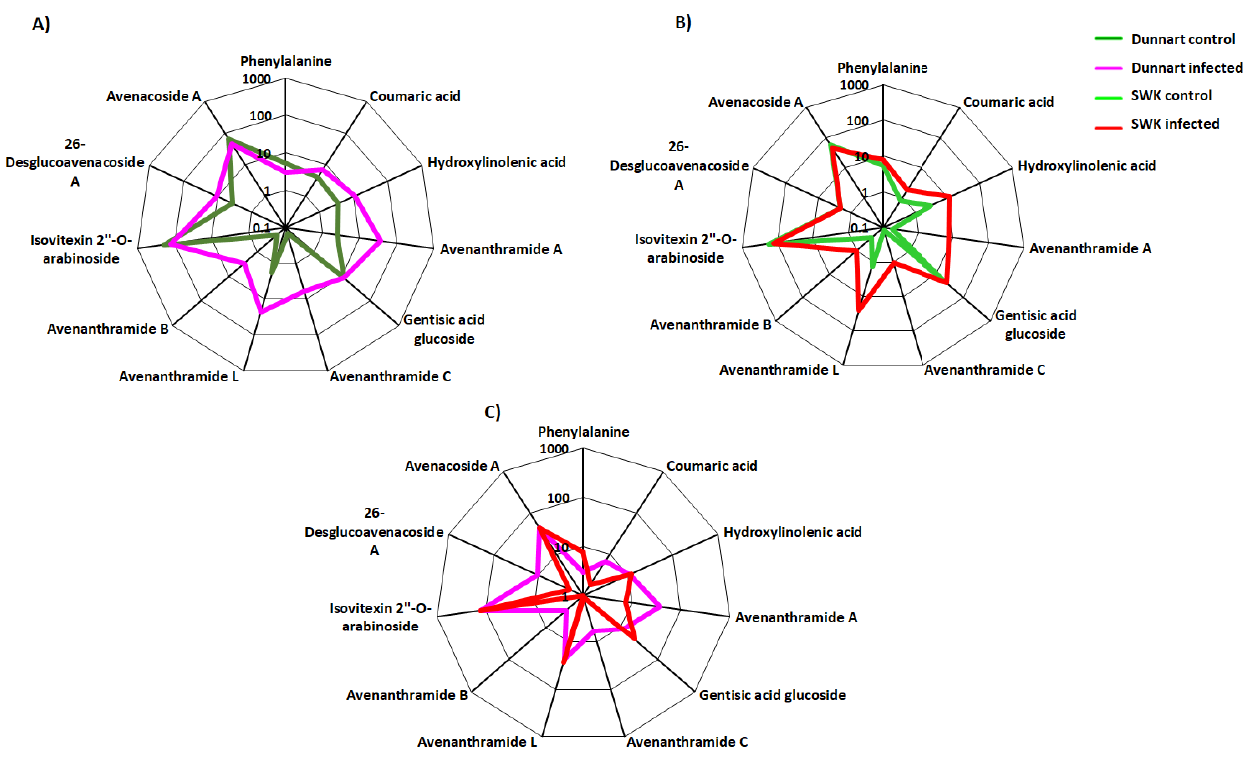
Figure 10. Radar charts illustrating relative intensities of selected biomarker metabolites across the different treated and control groups of the oat cultivars. ( A ) “Dunnart” infected vs. control, ( B ) “SWK001” infected vs. control and ( C ) “Dunnart” infected vs. “SWK001” infected. The relative peak intensities were averaged and illustrated as log-transformed values. The Venn diagram displays the partial overlap and differences of the statistically significant variables from the treated and control groups of the two cultivars. The numerical values illustrate the metabolites that were unique to the respective cultivars and treatments (Figure 7). The “Dunnart” infected group shows the presence of several metabolite classes (phenols, fatty acids, flavonoids, phenolic amides, alkaloids, lipids and saponins) with the three unique phenolic amides (avenanthramide A–C) and 26-desglucoavenacoside A being among the metabolites involved in plant defence for this cultivar. Conversely, the “SWK001” cultivar lacked these phenolic amides and the 26-desglucoavencoside A saponin as discriminant ions. The only overlap illustrated between the defence responses of “SWK001” and “Dunnart” are the presence of traumatic acid and avenanthramide L as discriminatory variables for both these cultivars.